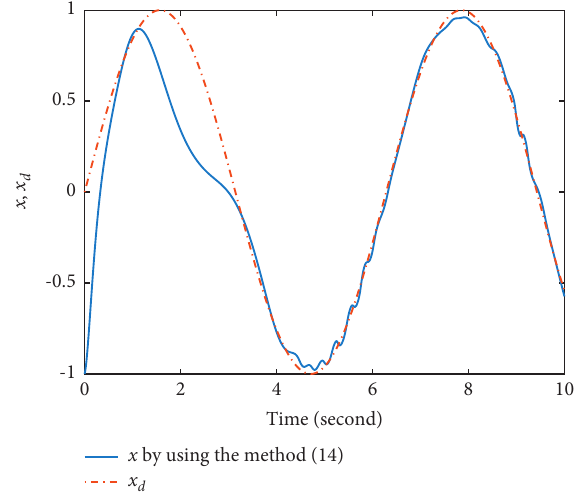
d by using method